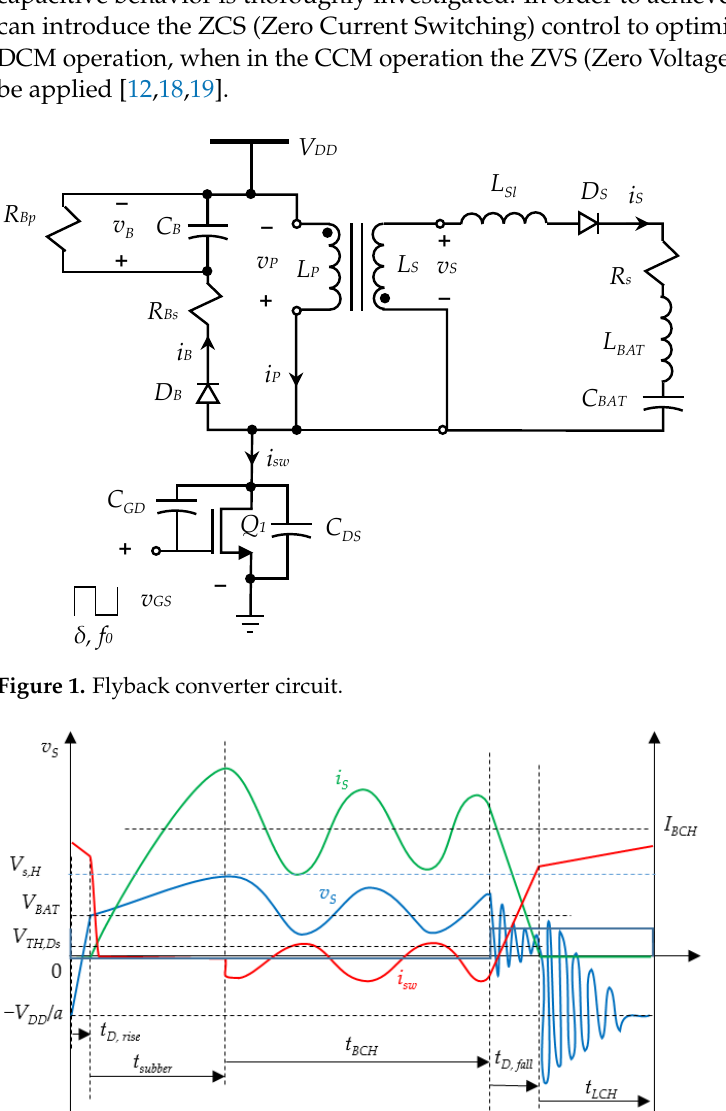
Figure 2. The assumed responses.